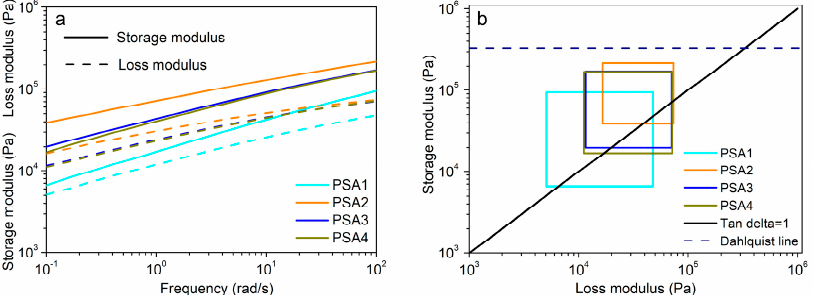
Figure 7. ( a ) Frequency sweeps of the four WPU-PSAs in the linear viscoelastic interval with an angular frequency range of 0.1 to 100 rad/s at 25 ◦ C. ( b ) Like Chan G (cid:48) s viscoelastic window of PSA1, angular frequency range of 0.1 to 100 rad/s at 25 °C. ( b ) Like Chan G ′ s viscoelastic window of PSA1, PSA2, PSA3 and PSA4 at 25 °C. The dash line represents the Dalquist criterion line. The black solid PSA2, PSA3 and PSA4 at 25 ◦ C. The dash line represents the Dalquist criterion line. The black solid line indicates G ′ = G ″ (tan delta = 1). line indicates G (cid:48) = G (cid:48)(cid:48) (tan delta =